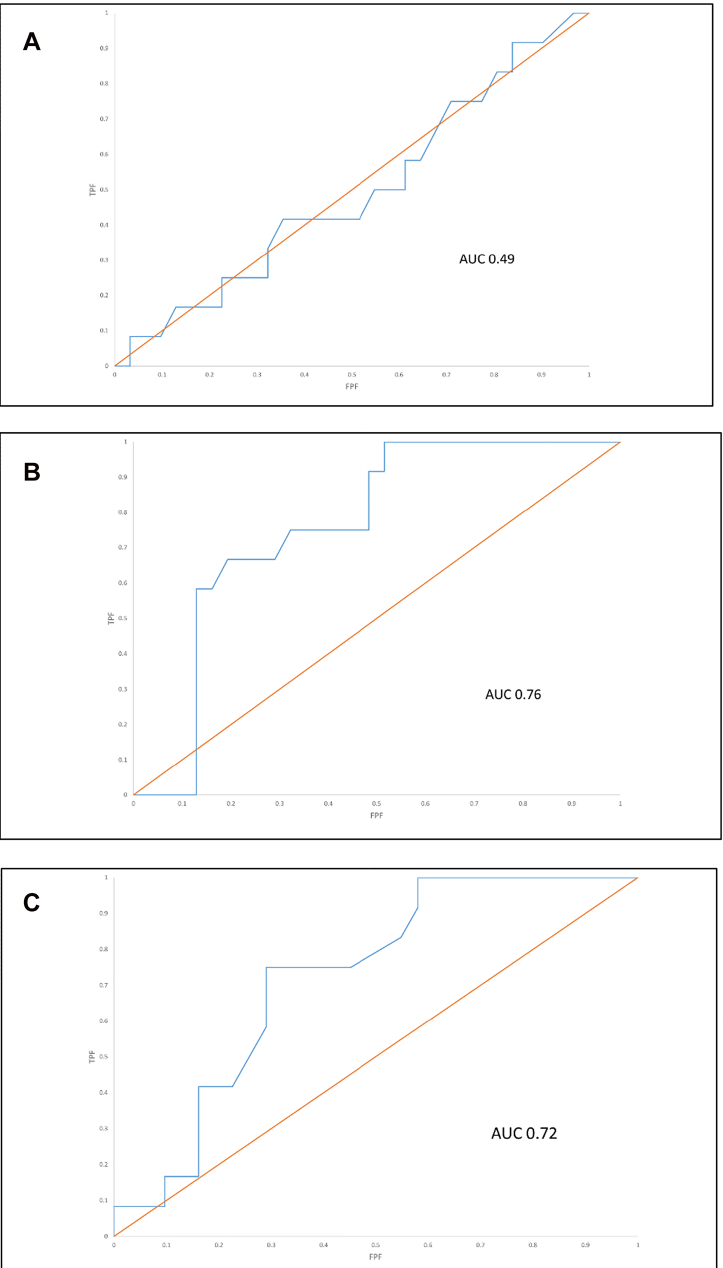
Fig 4. Receiver-operating curves for the outcome of operative delivery (emergency CS or operative vaginal delivery) for suspected fetal compromise among those who underwent labour (n = 12/43) using customised birthweight centile (Fig 4a), change in fetal weight centile between 28 – 36 weeks (Fig 4b) and change in fetal weight centile between 28 weeks-birth (Fig